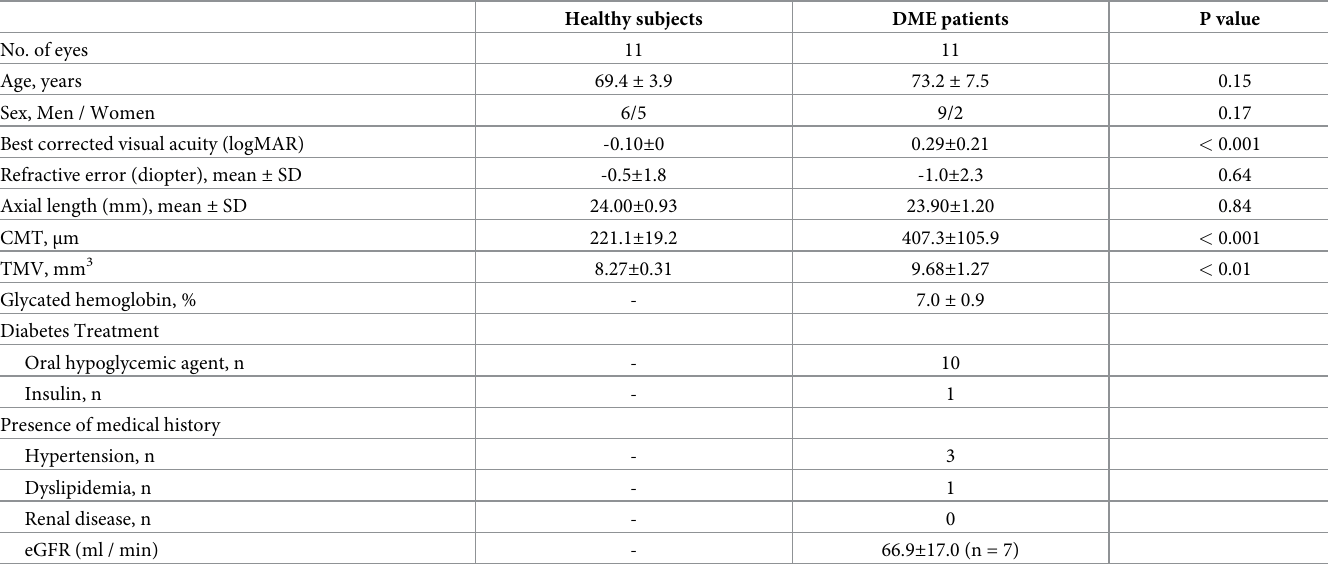
Table 1. Basic clinical characteristics of DME patients and healthy